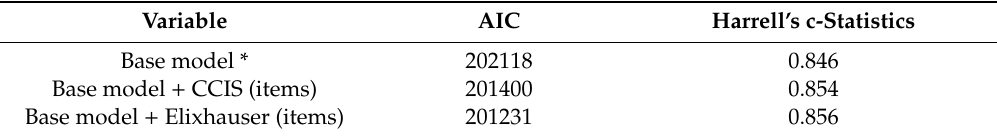
Table 6. The 17-year Survival Comparison of Charlson and Elixhauser Comorbidities in Patients with